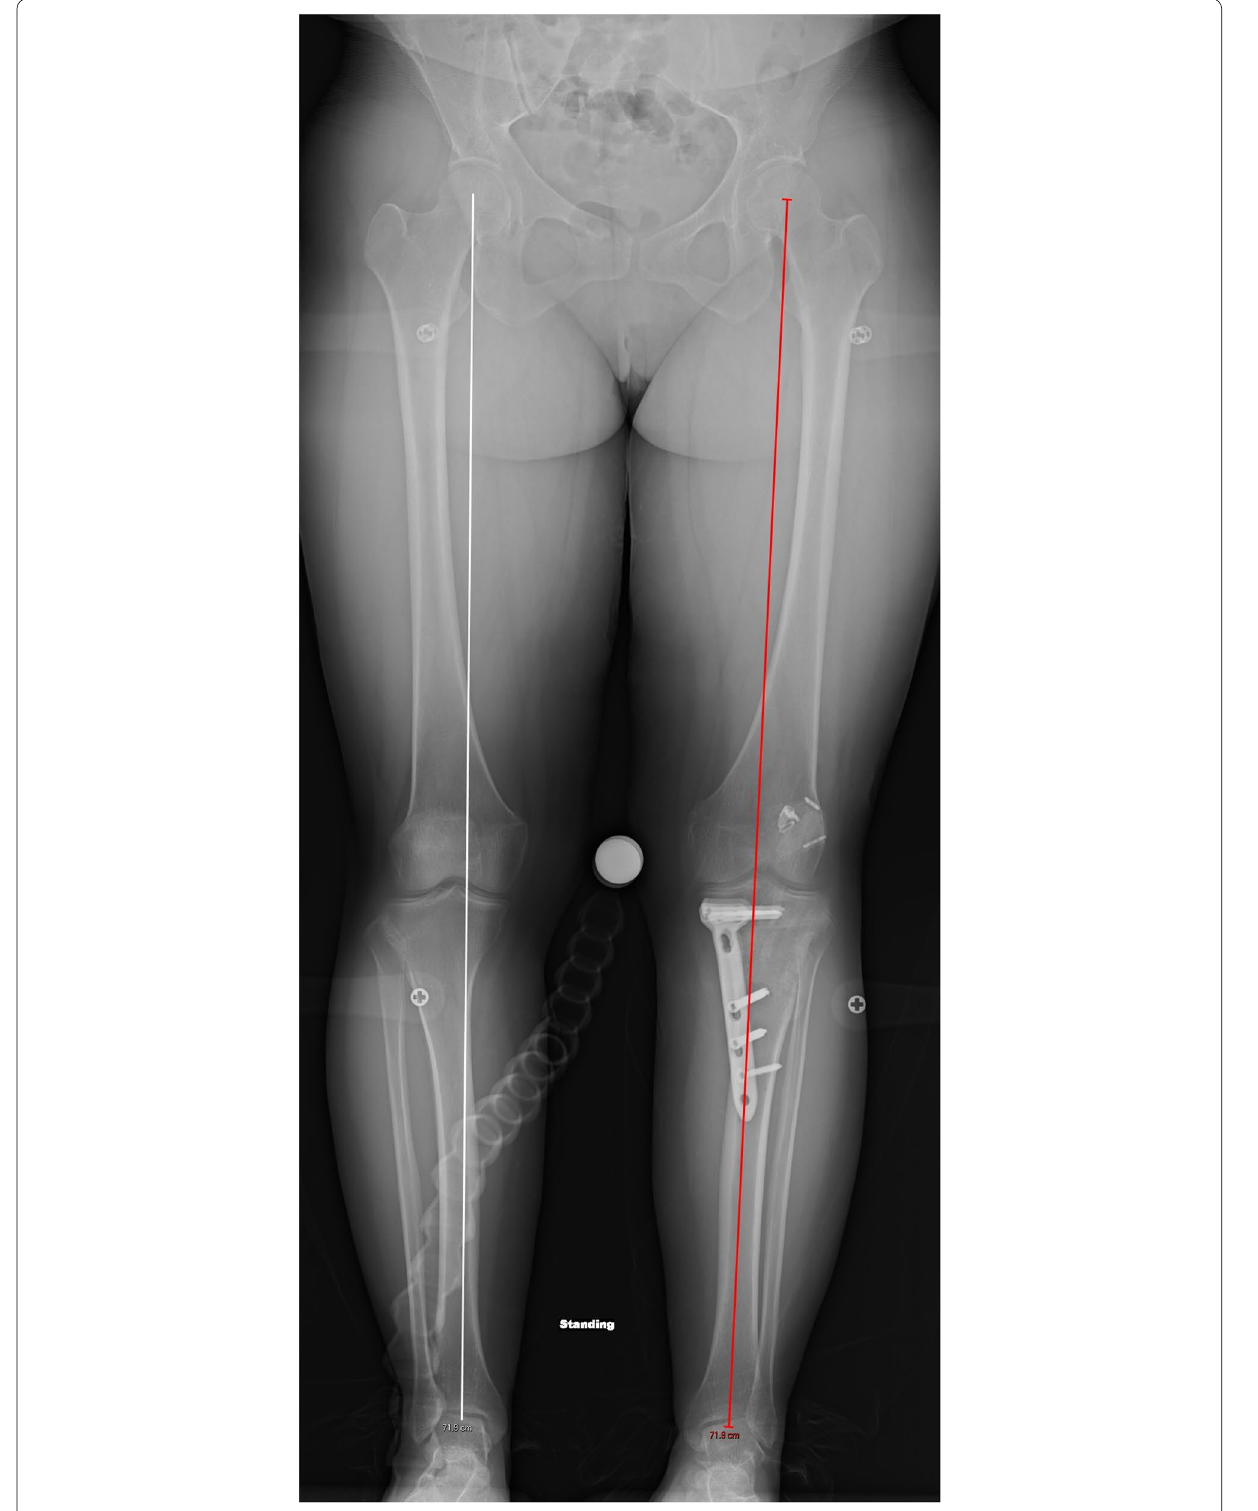
Fig. 5 A post-operative standing mechanical axis radiograph after revision osteotomy and ACL reconstruction demonstrating neutral